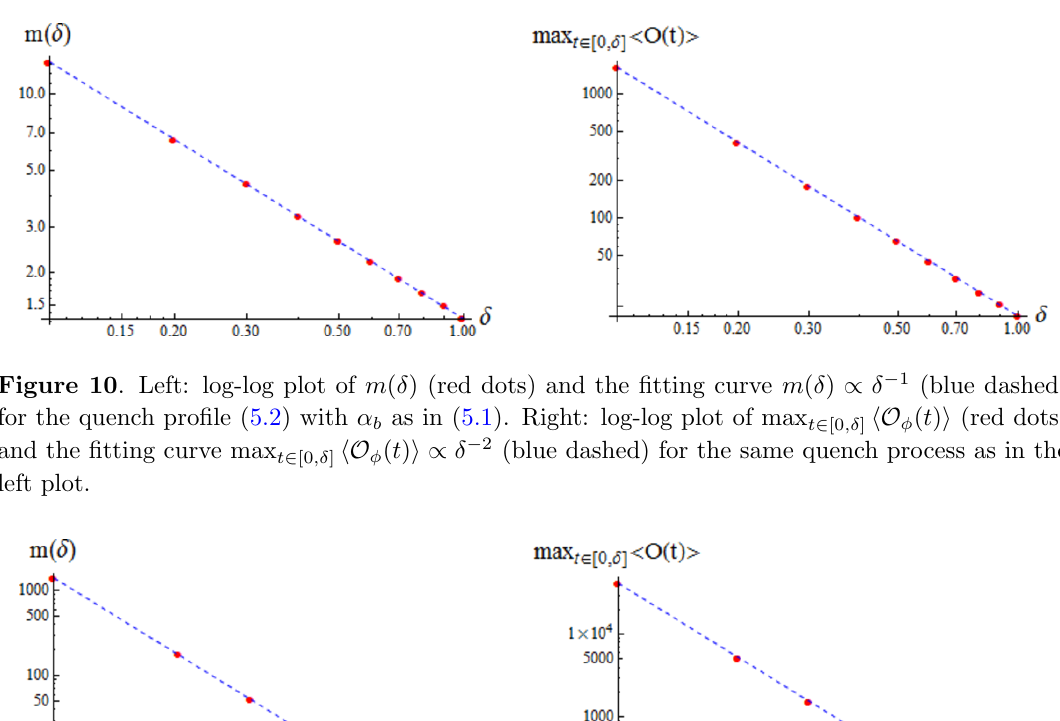
hO (cid:30) ( t ) i t 2 [0 ;(cid:14) ]